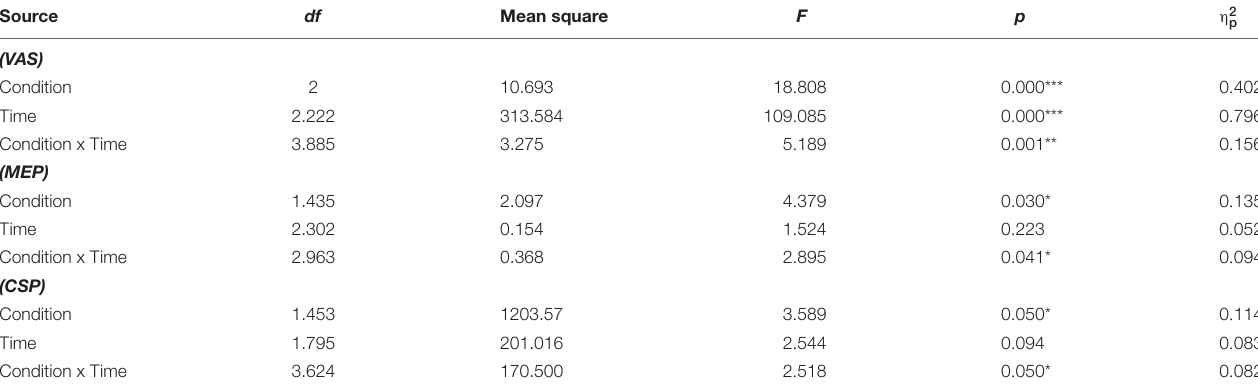
TABLE 1 | Summaries of ANOVA results.